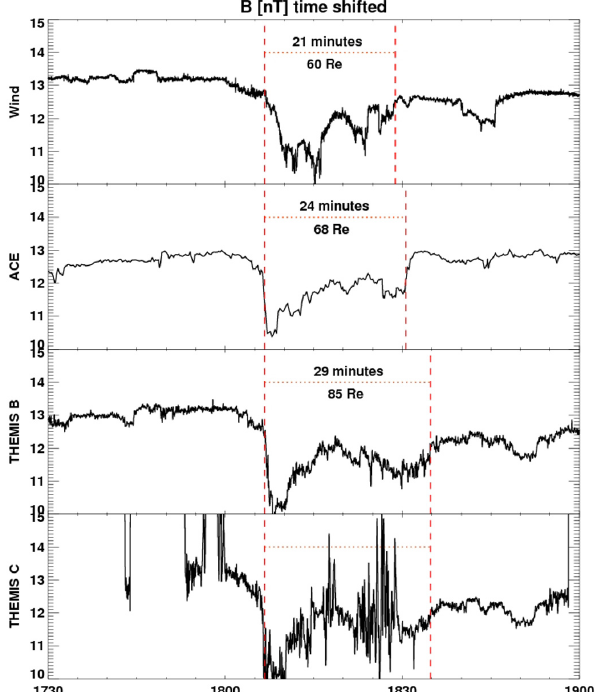
Fig. 5. Time-shifted magnetic field observation according to Wind: Wind, ACE − 27min, THEMIS B+42min and THEMIS C+46min. The red dashed lines depict the depletion halo onset and end, and different time duration and estimated width: Wind − 21min (60 R E ), ACE − 24min (68 R E ), and THEMIS B and C − 29min (85 R E ).